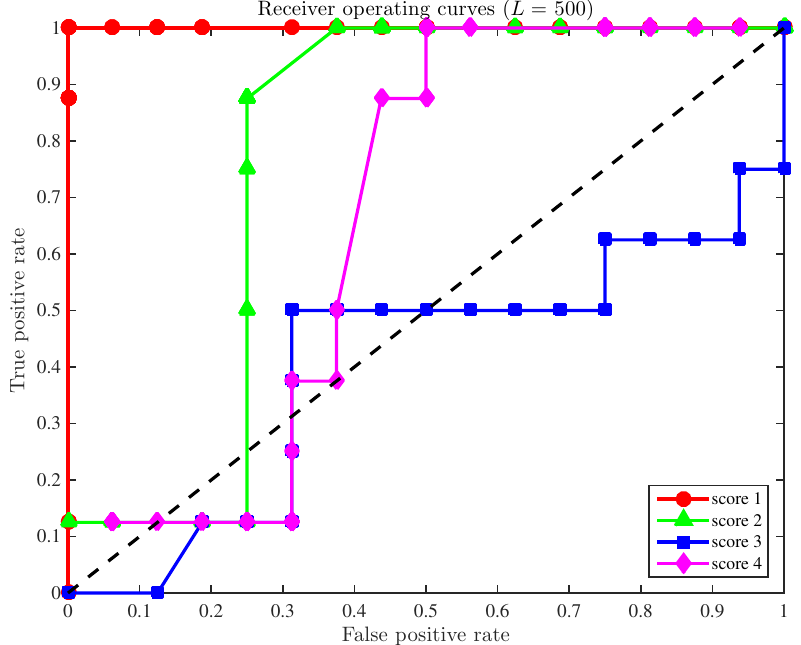
Figure 8. The ROCs for the four scores when the number of time instants per row is L =